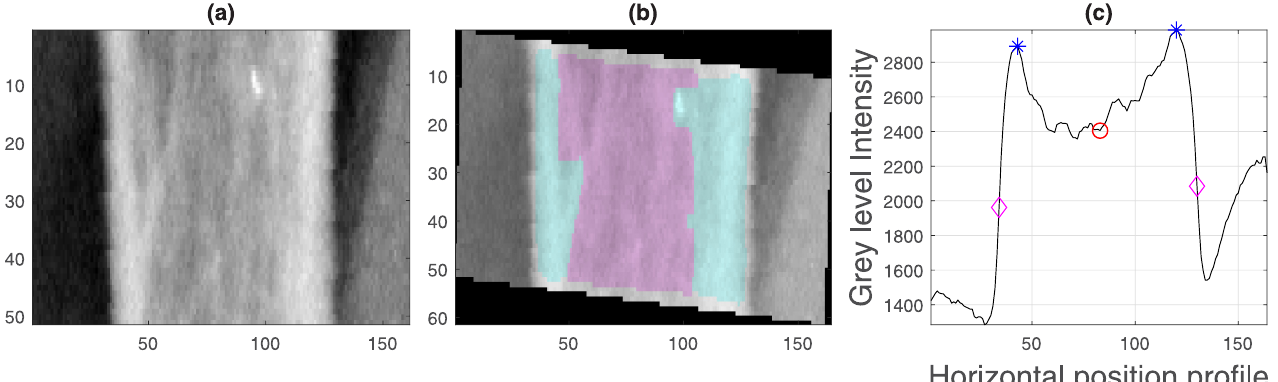
Fig 7. Semi-automatic extraction of measurements of the finger (a) Region of interest (ROI) of the central finger generated from the landmark, blue dot in Fig 5a. (b) Identification of regions of cortical bone (shaded in cyan) and trabecular bone (shaded in pink) from which the ratio of cortical to total area was calculated. Notice that the finger was rotated to align vertically as the previous rotation aligned the forearm but the fingers are not necessarily vertical. (c) Intensity profile of the ROI with the following key points: edges of the bone (magenta diamond), peak of cortical bone (blue asterisk) and centre of bone (red